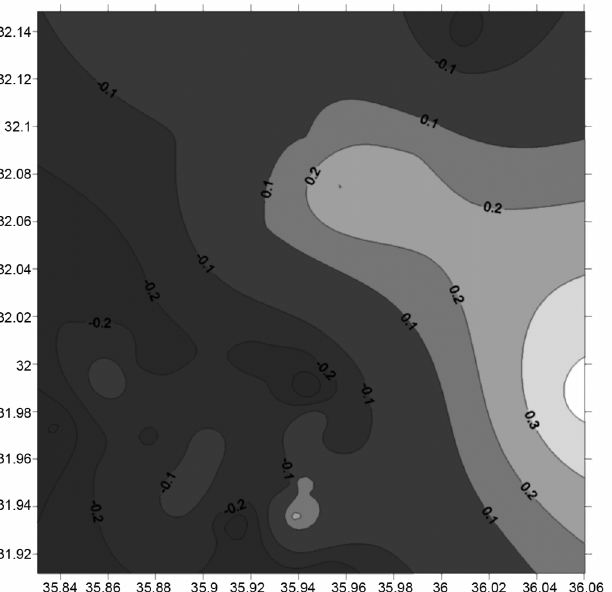
Fig. 9. Differences in meters, between Experimental Undulation (GPS/Leveling data) and gravimetric Jordan- ian Geoid Model (GeoJordan) after fitting (latitude and longitude in